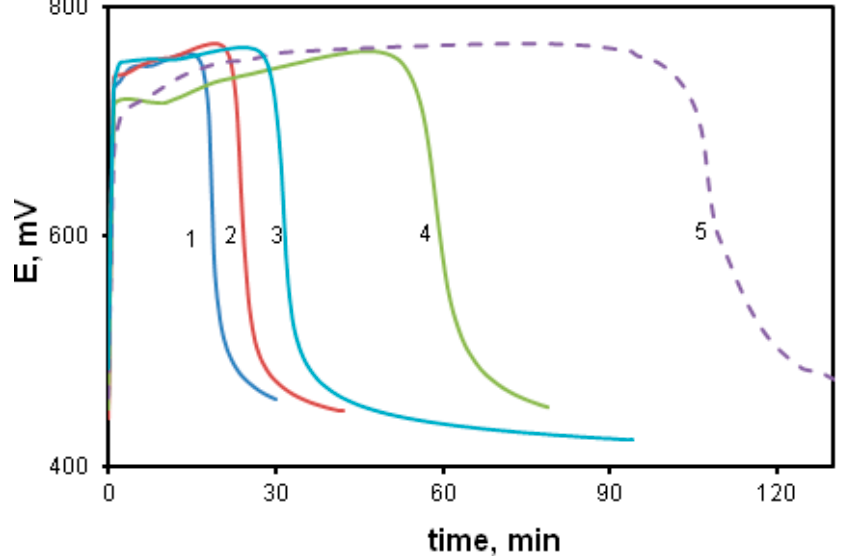
Figure 2. Changes in redox potential with time at the oxidation of DADCB: [DADCB] = 0.05 mol/L (1), 0.03 mol/L (2), 0.02 mol/L (3), 0.005 mol/L (4). (Standard conditions). (5)—polymerization of DACB at Т = 0 °C.